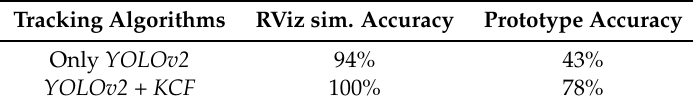
Table 1. Percentage accuracy of the system over 50 experiment